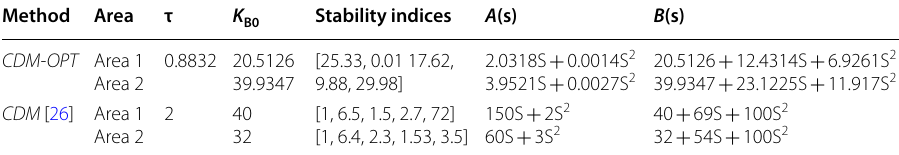
Table 2 CDM controller with and without WCA optimum values for two-area power